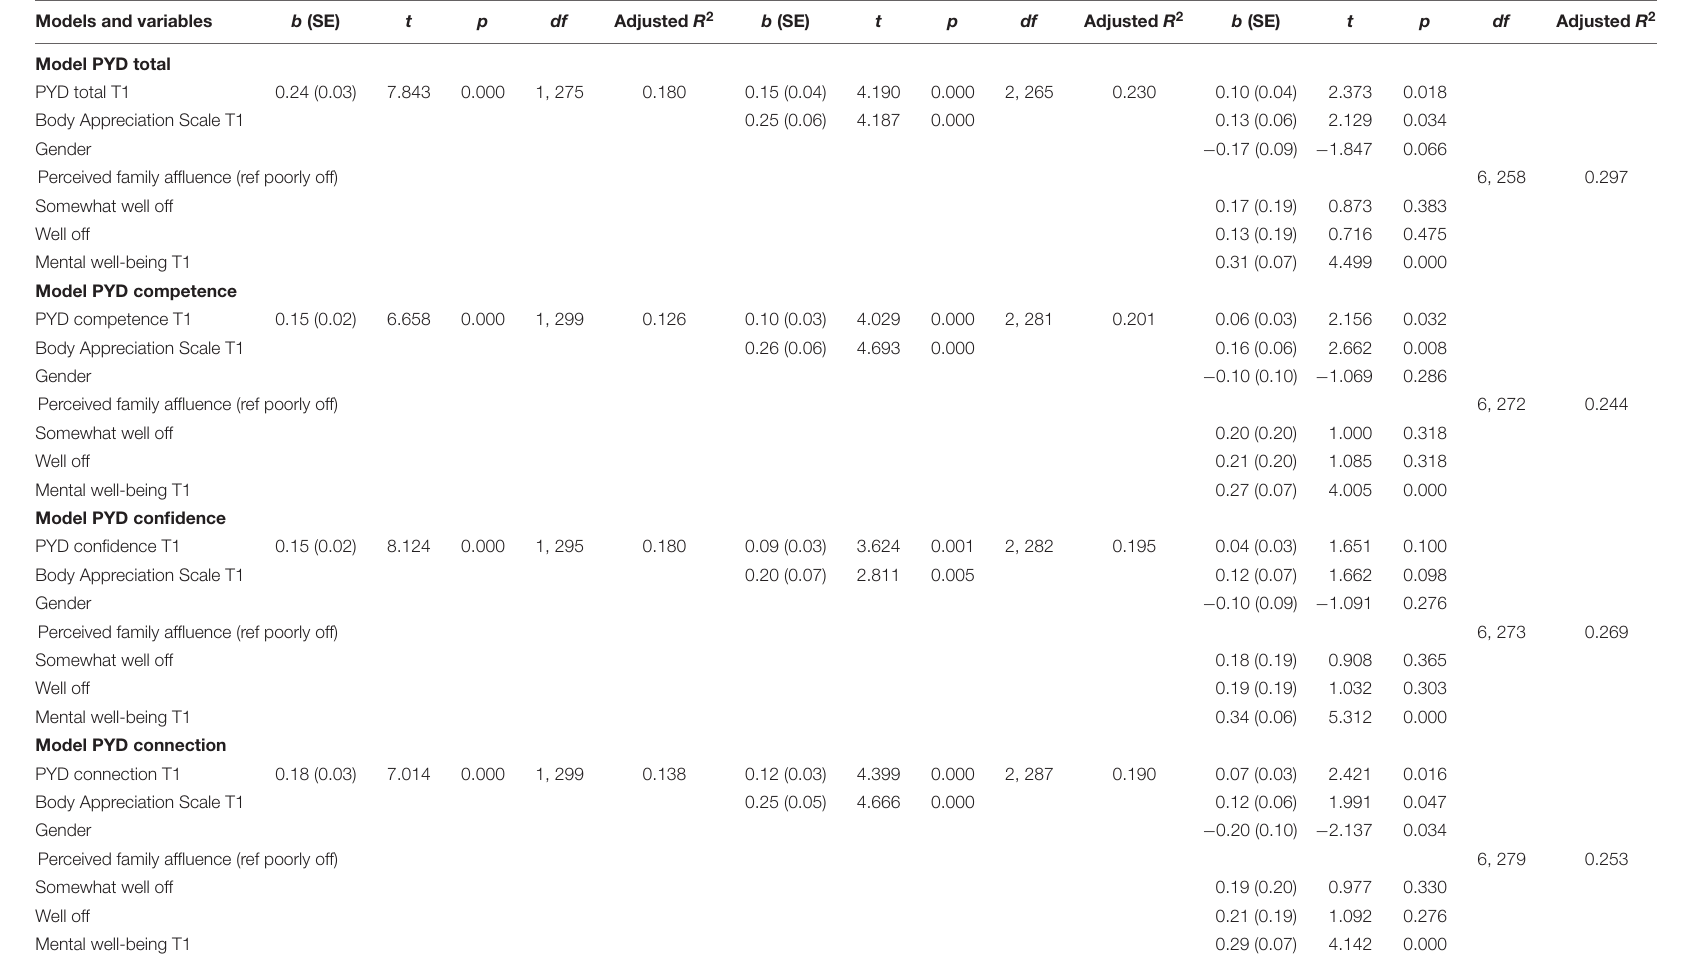
TABLE 3 | Hierarchical regression model examining the prospective relationship between positive youth development, body appreciation, and mental well-being, adjusting for gender, perceived family affluence, and mental well-being at time 1. Models and